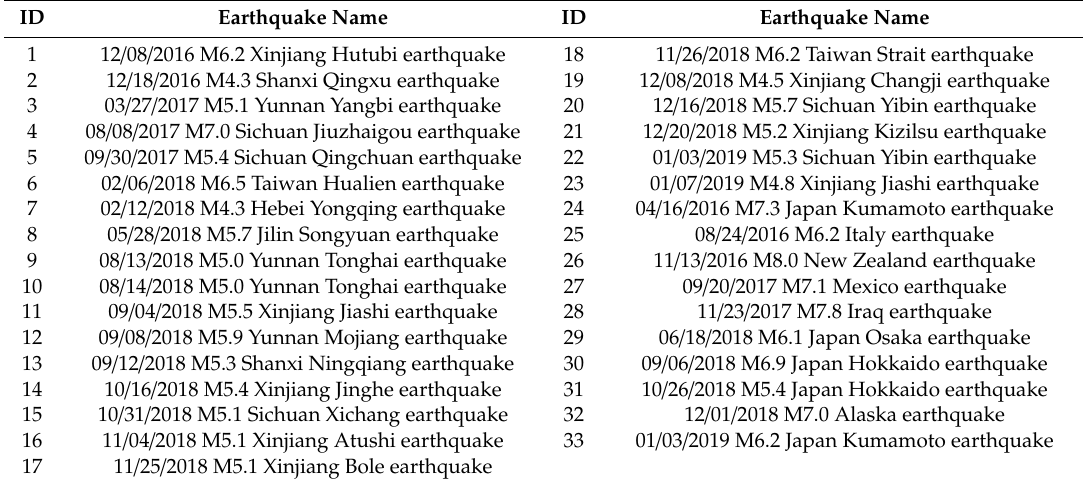
Table 2. Applications of the RED-ACT system.